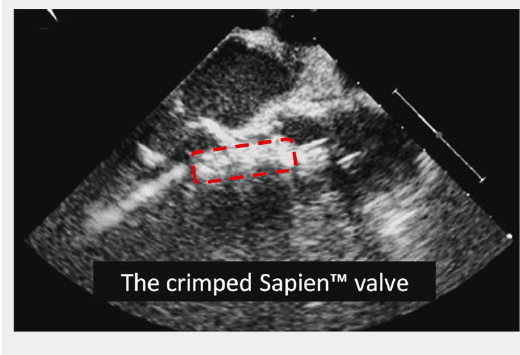
Image from the intraoperative transoesophageal echocardiogramme (TEE) showing the crimped Edwards Sapien TM THV during the positioning in the ideal landing zone. Landmarks such as the hinge point of the aortic valve leaflets and the anterior mitral valve leaflet are identified.